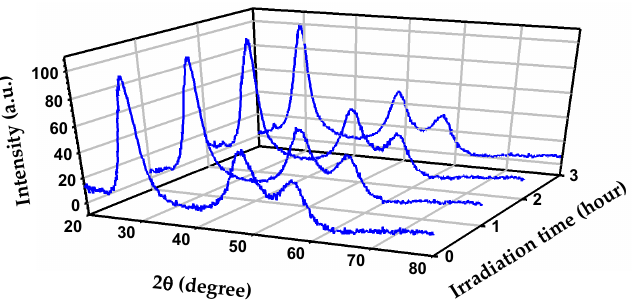
Figure 4. Powder XRD patterns for ZnS before (0 h) and after 1, 2, and 3 h of irradiation. Further